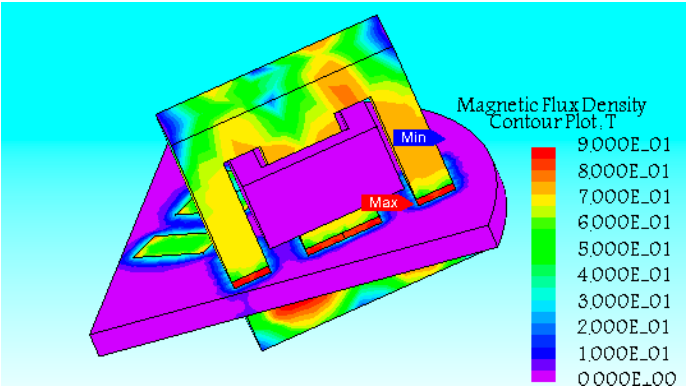
Figure 12. Contour plot for flux density distribution of the generator in open circuit mode. Also, in this mode, the lines of magnetic flux density in a pair of pole of the machine are shown in Figure 13.